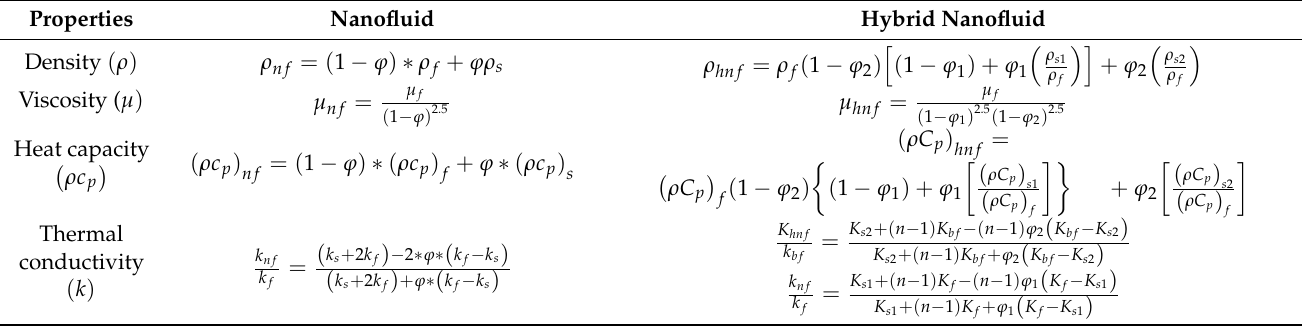
Table 3. Thermophysical property relations for both kind of fluids. Reprinted from Ref.